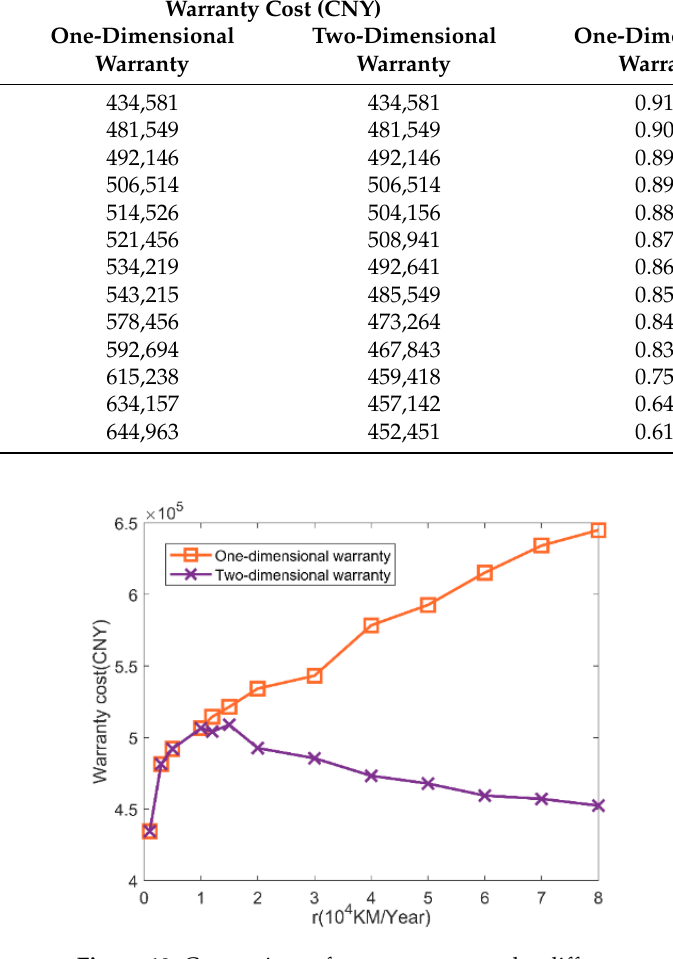
Figure 19. Comparison of warranty cost under different warranty methods.